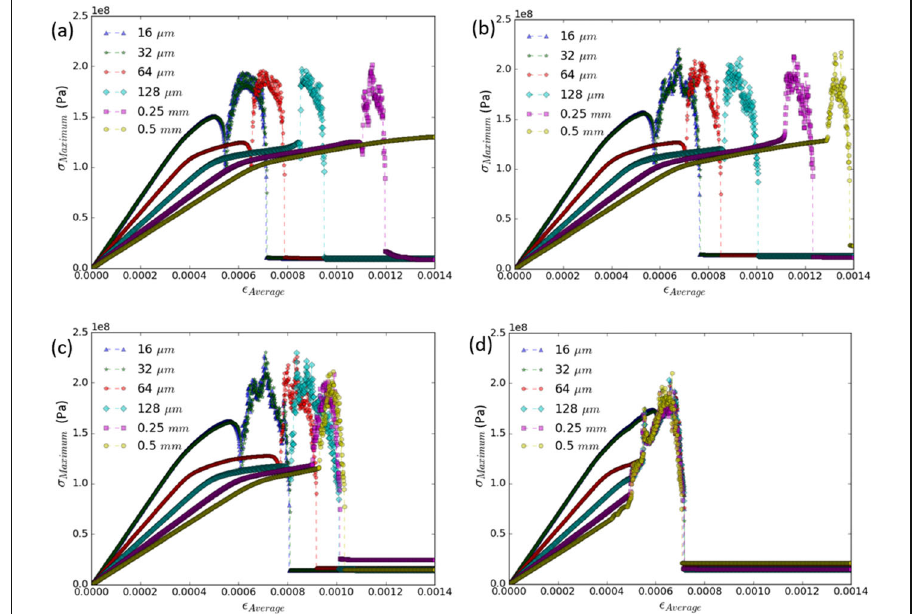
Fig. 7 Effect of disorder on maximum stress along loading z-direction: The maximum stress of samples